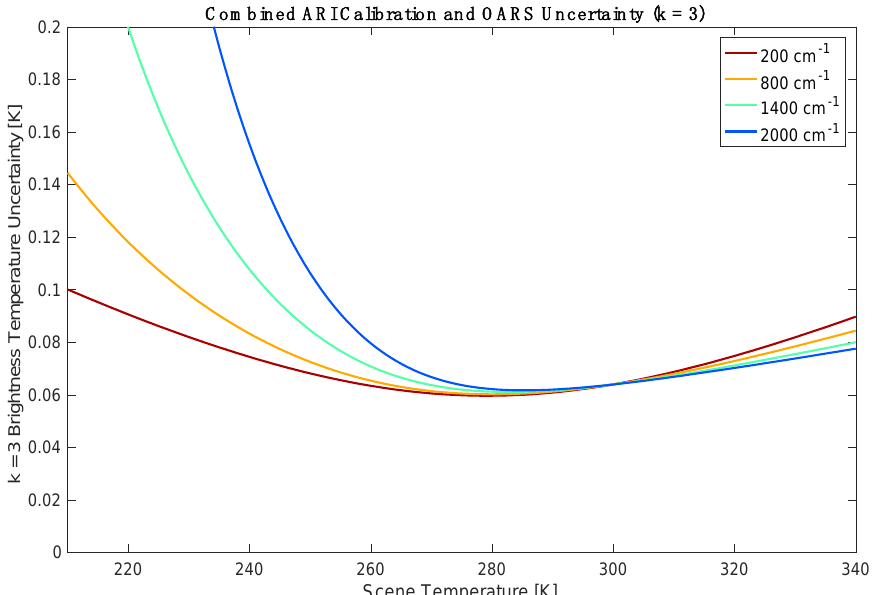
Figure 10. Predicted vacuum combined radiometric calibration and verification uncertainty (k = 3).